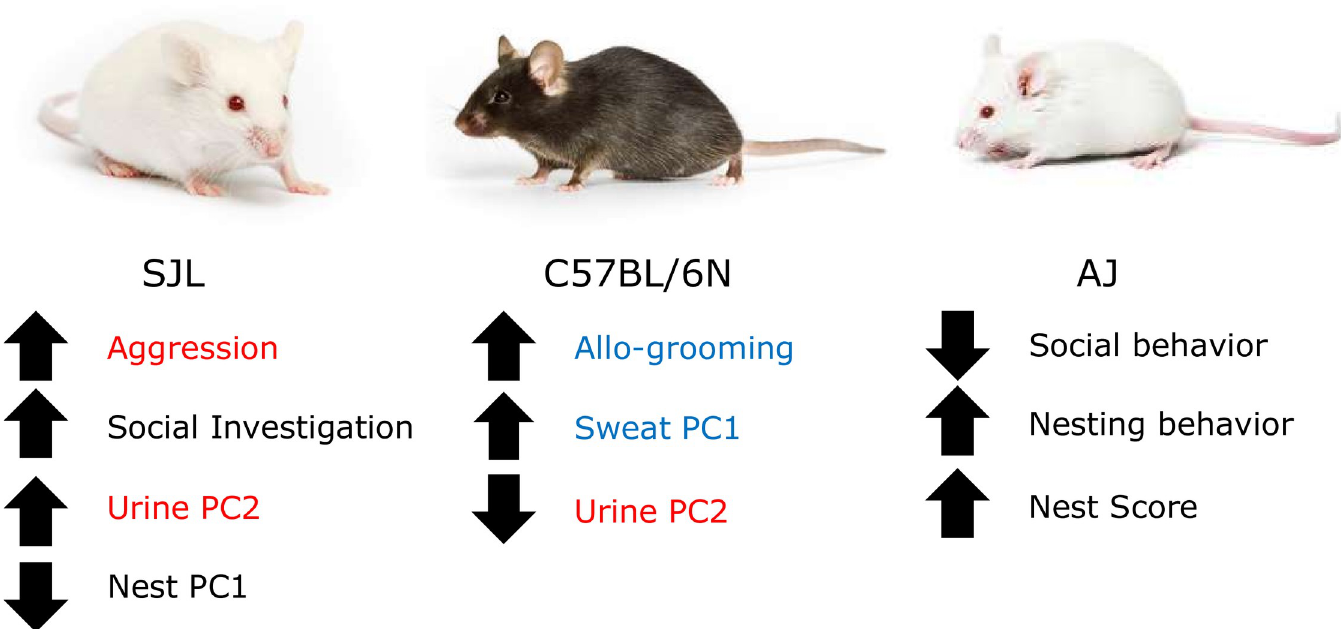
Fig 6. Summary diagram of observed strain patterns. Variables that were associated with aggressive behavior are listed in red, while those associated with an affiliative behavior are listed in blue.